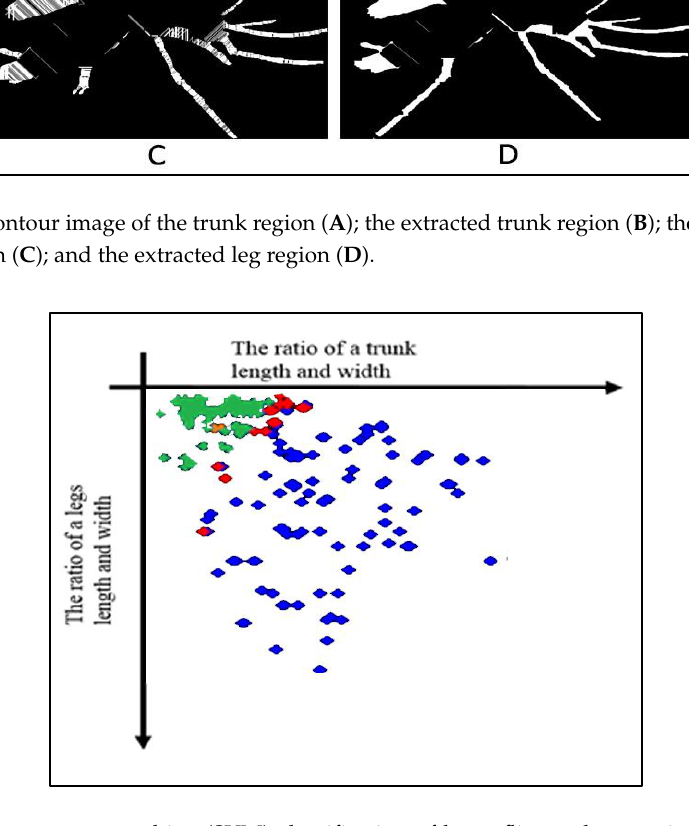
Figure 6. Support vector machine (SVM) classification of bees, flies and mosquitoes (green color indicates correctly identified bees or flies, blue color indicate correctly identified mosquitoes, red color indicates the incorrect identification of bees or flies, and orange color indicate the incorrect identification of mosquitoes).